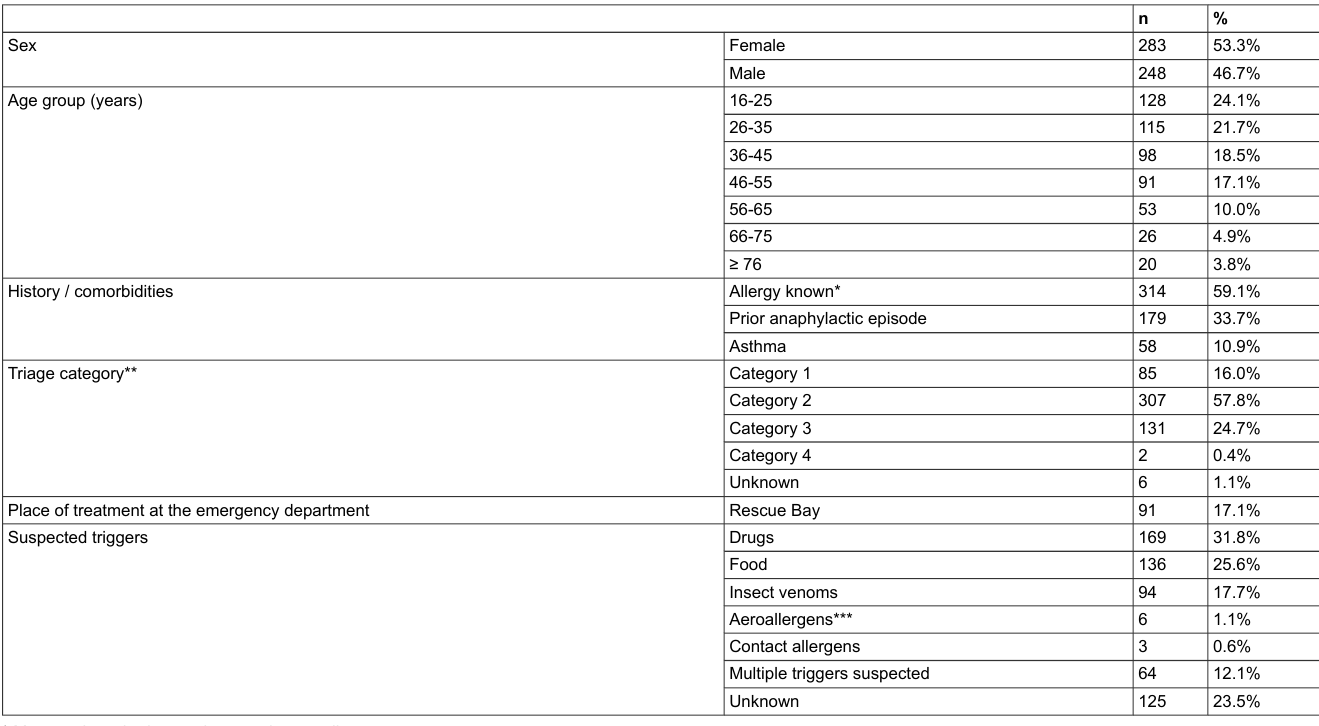
Table 1: Demographic data, n = 531.